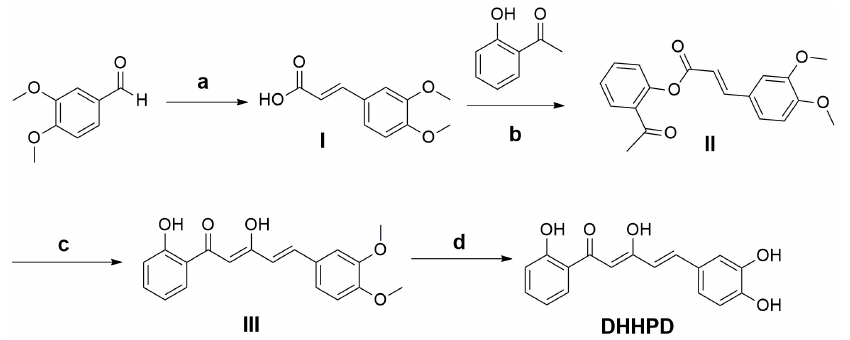
Figure 7. Synthesis of DHHPD . Reagents and Conditions : ( a ) malonic acid, pyridine, reflux process (4 h); ( b ) POCl 3 , pyridine, RT (overnight); ( c ) KOH, pyridine, RT (overnight); ( d ) BBr 3 , CH 2 Cl 2 , 0 °C (8 h). Reaction scheme and description adapted from